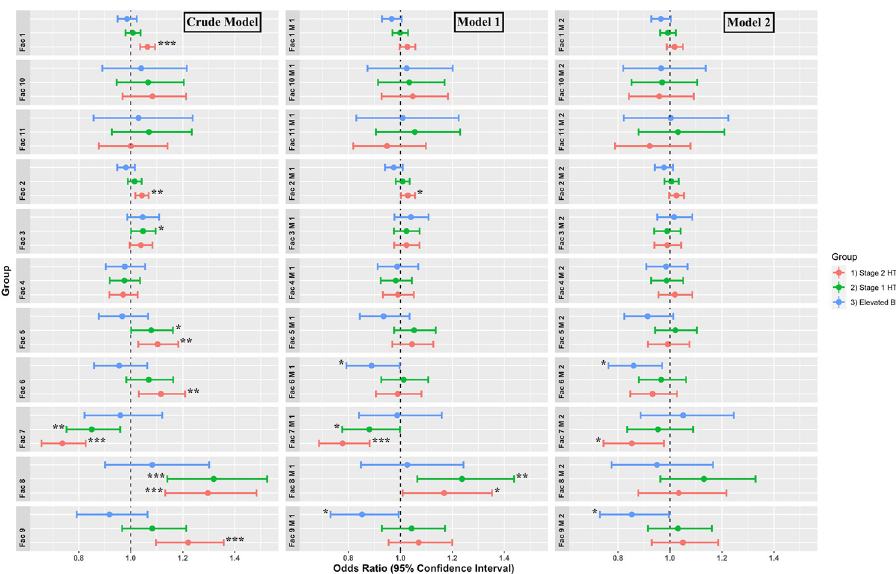
Fig 2. The likelihood of elevated BP, stage 1 HTN, and stage 2 HTN based on metabolite-derived factors in crude model, model 1 (adjusting for age, sex, and BMI), and model 2 (adjusting for age, sex, BMI, total cholesterol, triglyceride, HDL cholesterol, FPG, oral glucose-lowering drugs use, statins use, and antihypertensive drugs